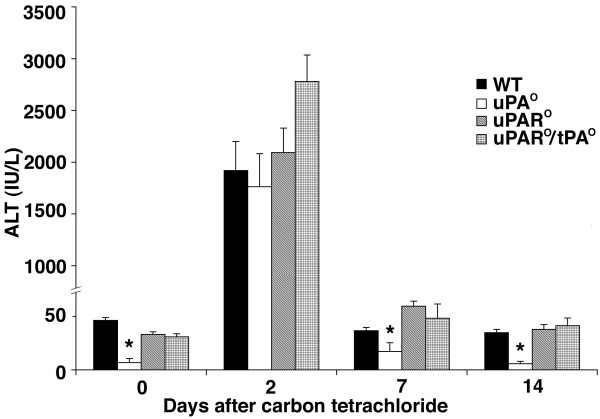
Levels of serum alanine aminotransferase (ALT) after CCl 4 . Serum levels of ALT peak 2 days following CCl4 administration in mice of all genotypes. Thereafter, the values return to basal levels within 7 to 14 days in a similar manner in all experimental groups (n = 3–8 at each time point). * P = 0.023 when compared experimental controls.